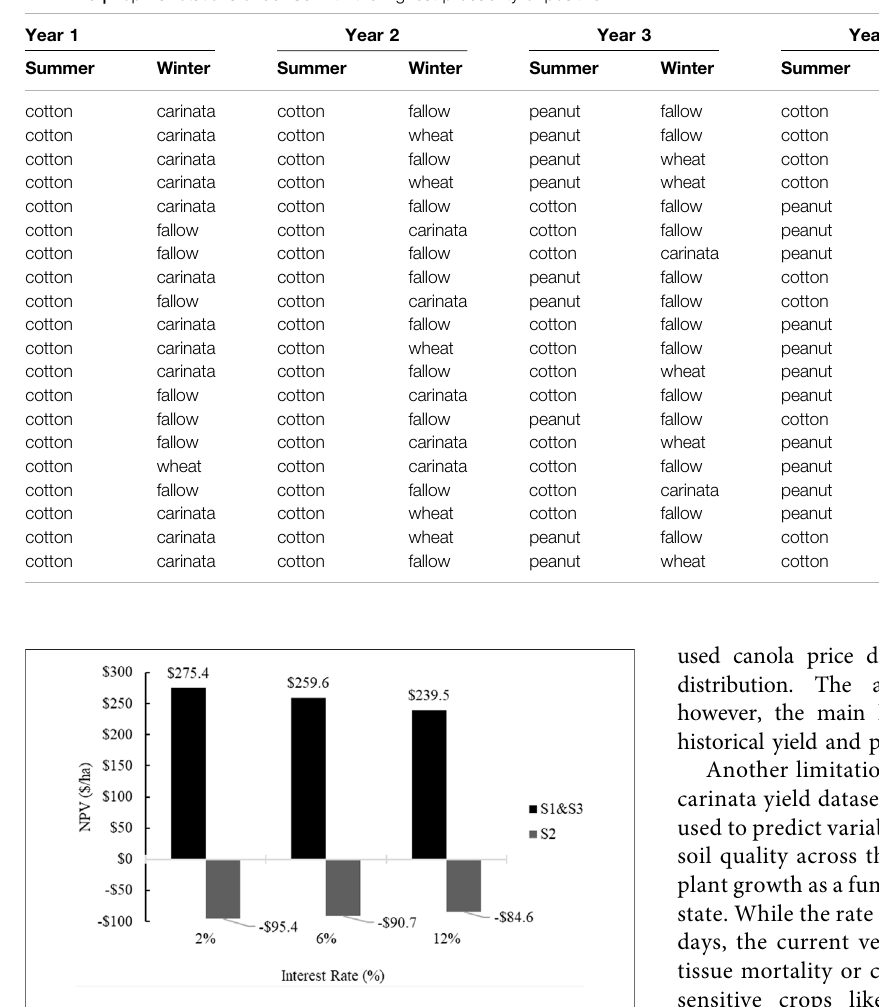
TABLE 8 | Top 20 rotations under S3 with the highest probability of positive NPV.